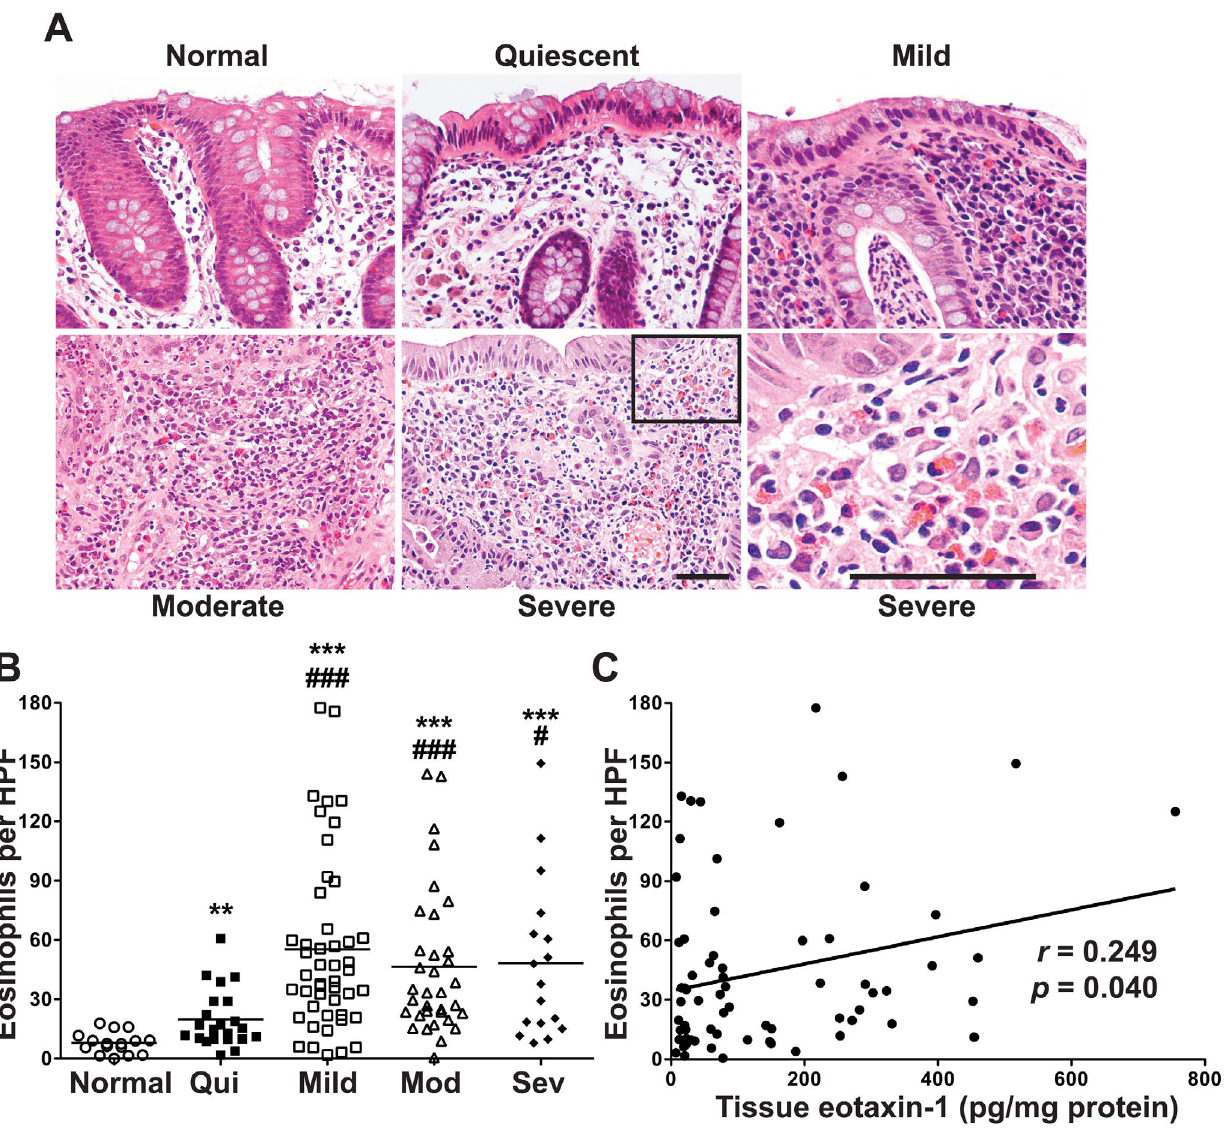
Figure 6. Increased tissue eosinophils in UC patients and relationship to tissue eotaxin-1 levels. As we did not have paraffin-embedded samples from the non-UC control subjects, we used a subset of 16 cases from our UC study patients who had completely normal histology in all of their colon biopsies at the time of the study colonoscopy as the normal group for this set of studies. (A) H&E sections from normal, quiescent, and active UC groups. (B) Number of eosinophils per HPF. ** p , 0.01; *** p , 0.001 vs. normal. # p , 0.05; ### p , 0.001 vs. quiescent colitis. n =16 for normal, and n =120 for UC. C : Correlation of tissue eotaxin-1 levels with eosinophil infiltration in active UC subjects with a b =0.068. n =68 paired samples.